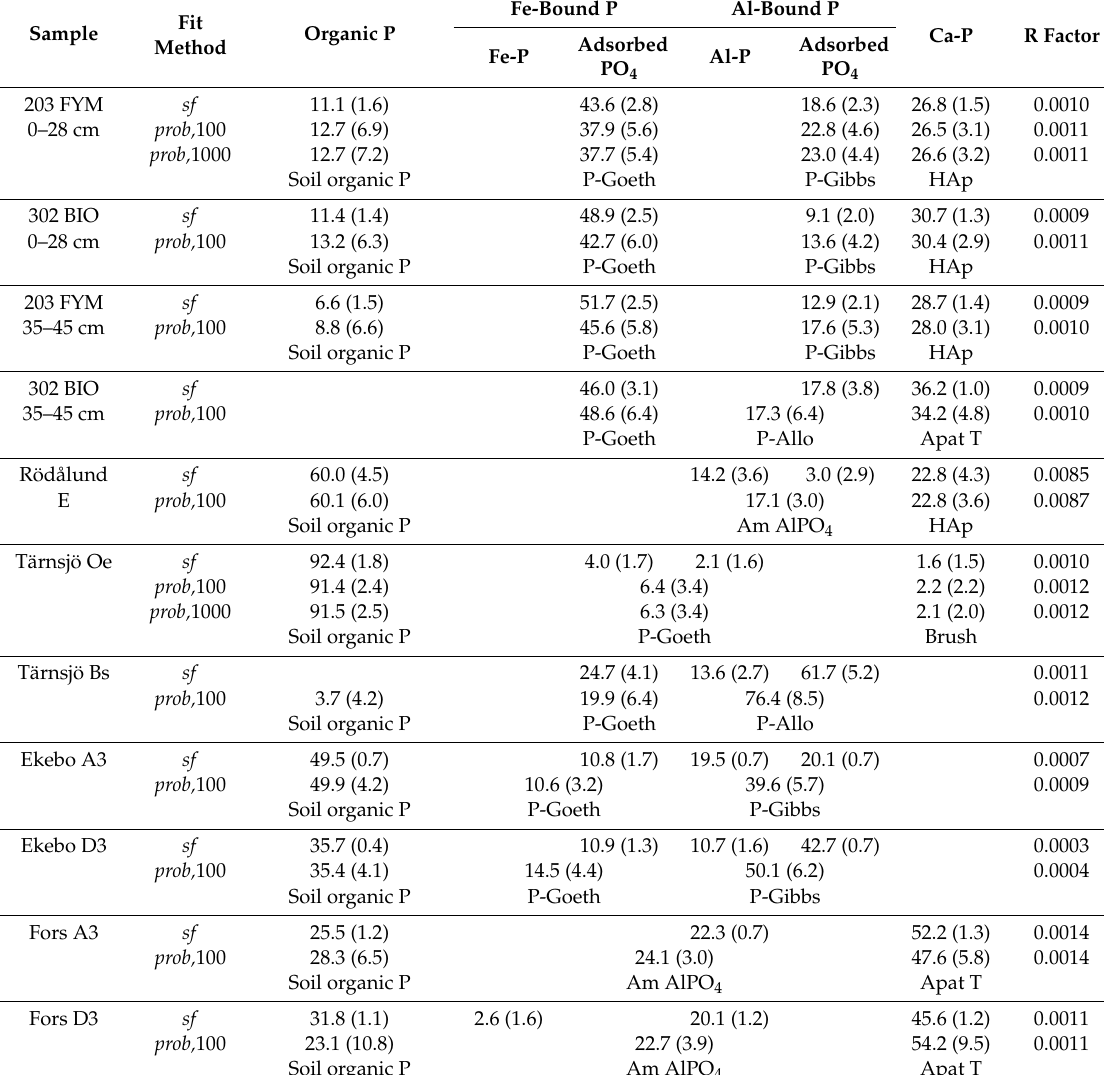
Table 3. Relative phosphorus speciation in soil samples (%) as evidenced from LCF using the single fit ( sf ) and probabilistic ( prob ) methods. Standard deviations are shown within parenthesis. For each standard group included in the fit, the standard with the highest average weight is